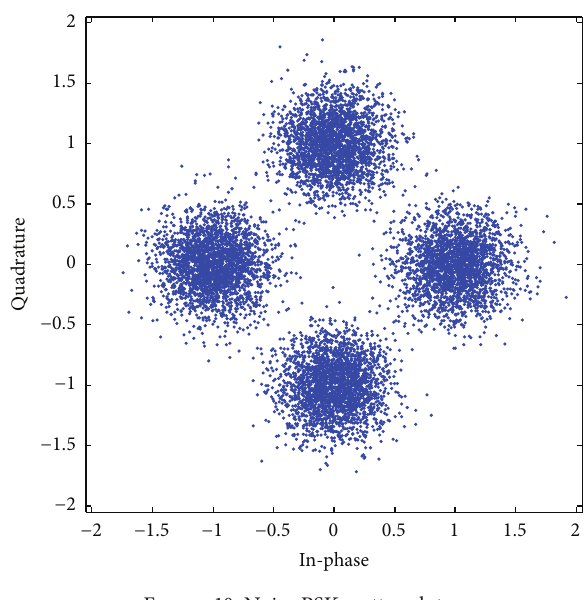
Figure 10: Noisy PSK scatter plot.